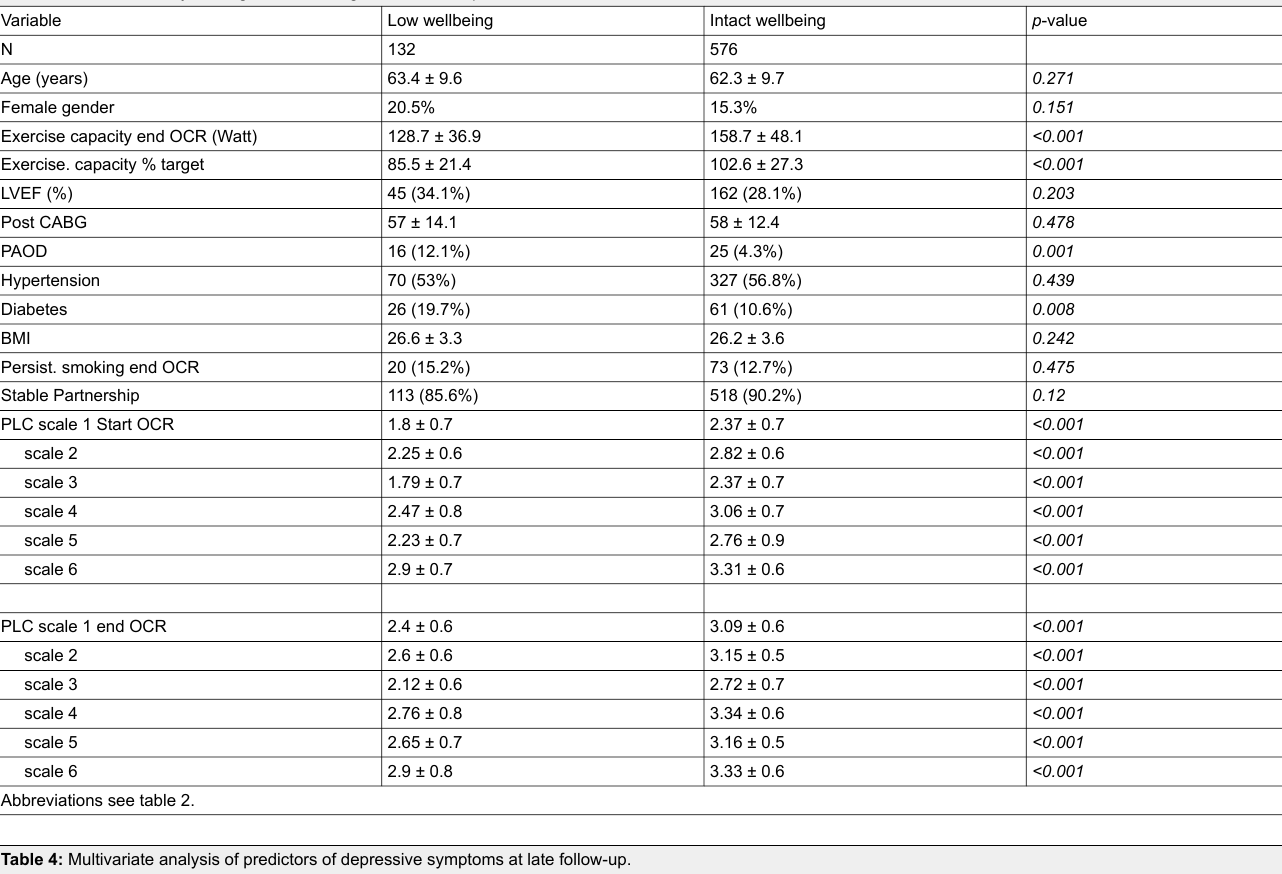
Table 3: Univariate analysis for global wellbeing at late follow-up.